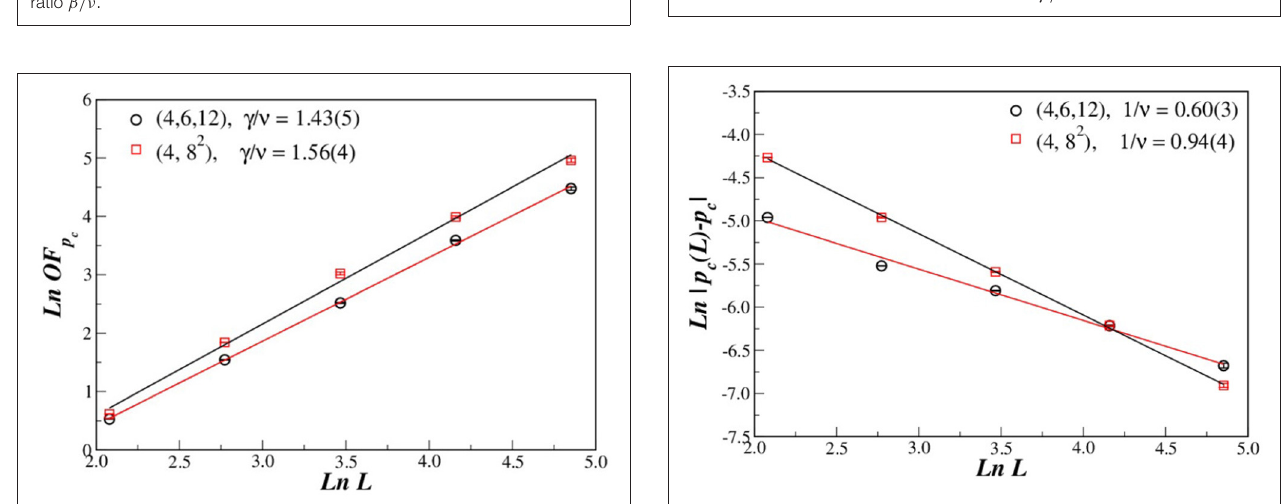
FIGURE 5 | OF at p χ max ( N ) vs. L for (4,6,12) and (8 2 ), AL. Fitting data, we obtained another estimation for the critical ratio γ/ν .